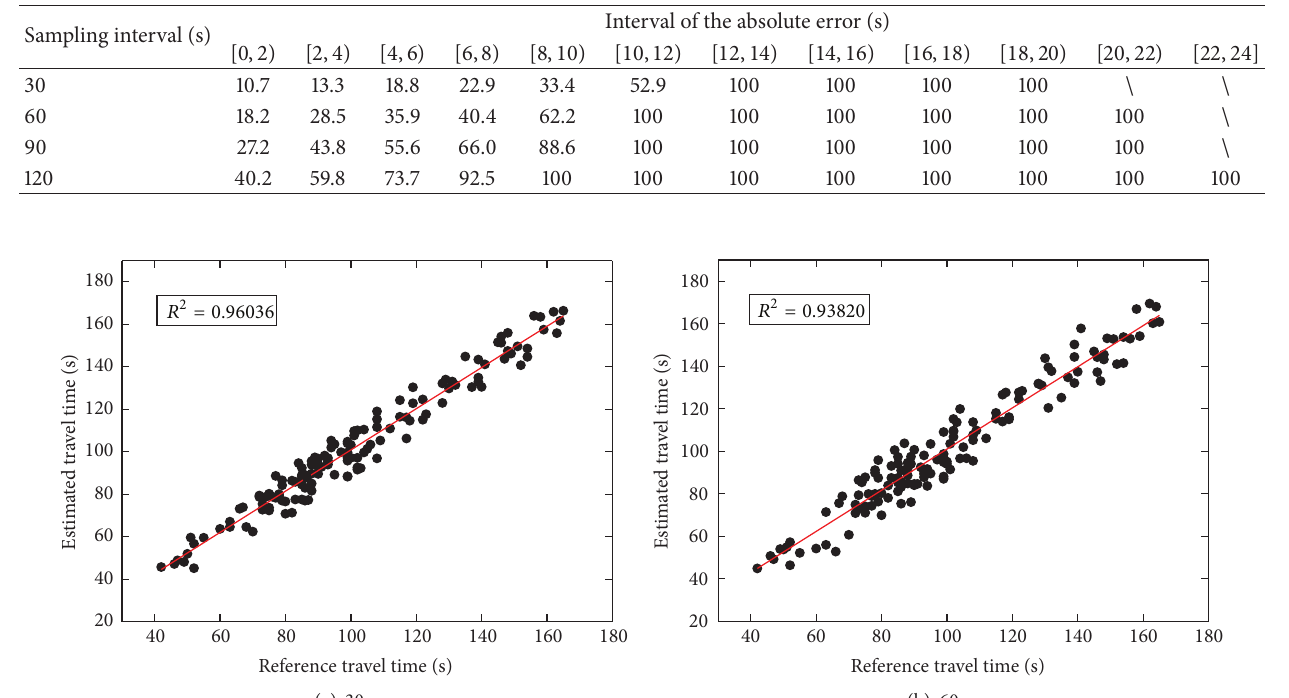
Table 3: Proportion of the studied case based on the proposed method (%).